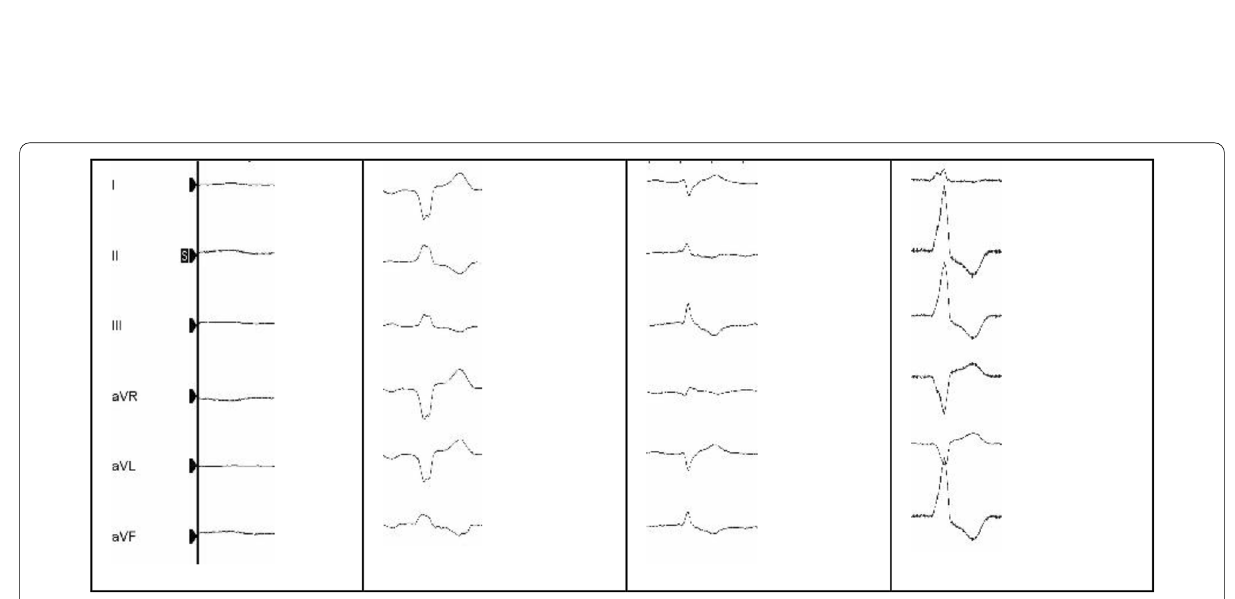
Fig. 2 Following Dixit and Zhang algorithms, anterior, mid and posterior localisation (from left to right panel) in the RVOT can be established based on the differences of QRS morphology in lead I and AVL. QRS polarity in lead aVL was assessed to determine the anterior or posterior arrhythmia locations. In the left panel, QS aspect in both lead I and AVL leads suggests an anterior location, while in the mid panel a R / S ratio < 1 and low R wave amplitude in I and AVL leads favours a mid to anterior location of the PVC. In the right panel, a R / S ratio > 1 in lead I suggests a posterior